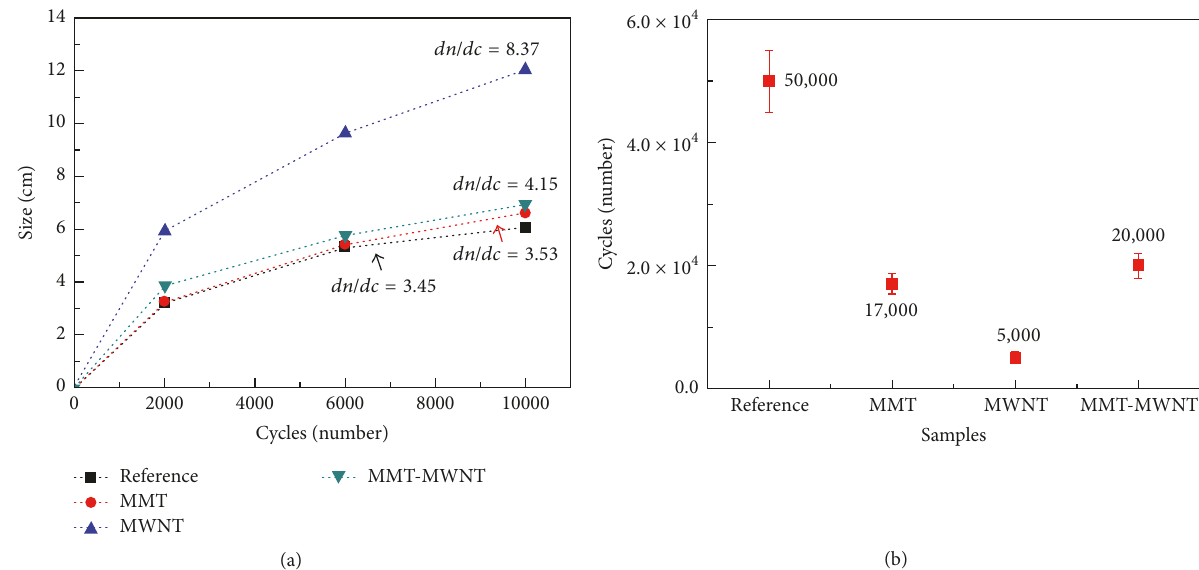
Figure 4: Fatigue properties of elastomer nanocomposites. (a) Fatigue properties (fatigue crack growth) of the elastomer composites with diverse fillers. (b) Fatigue properties (fatigue crack generation) of the elastomer composites with diverse fillers.